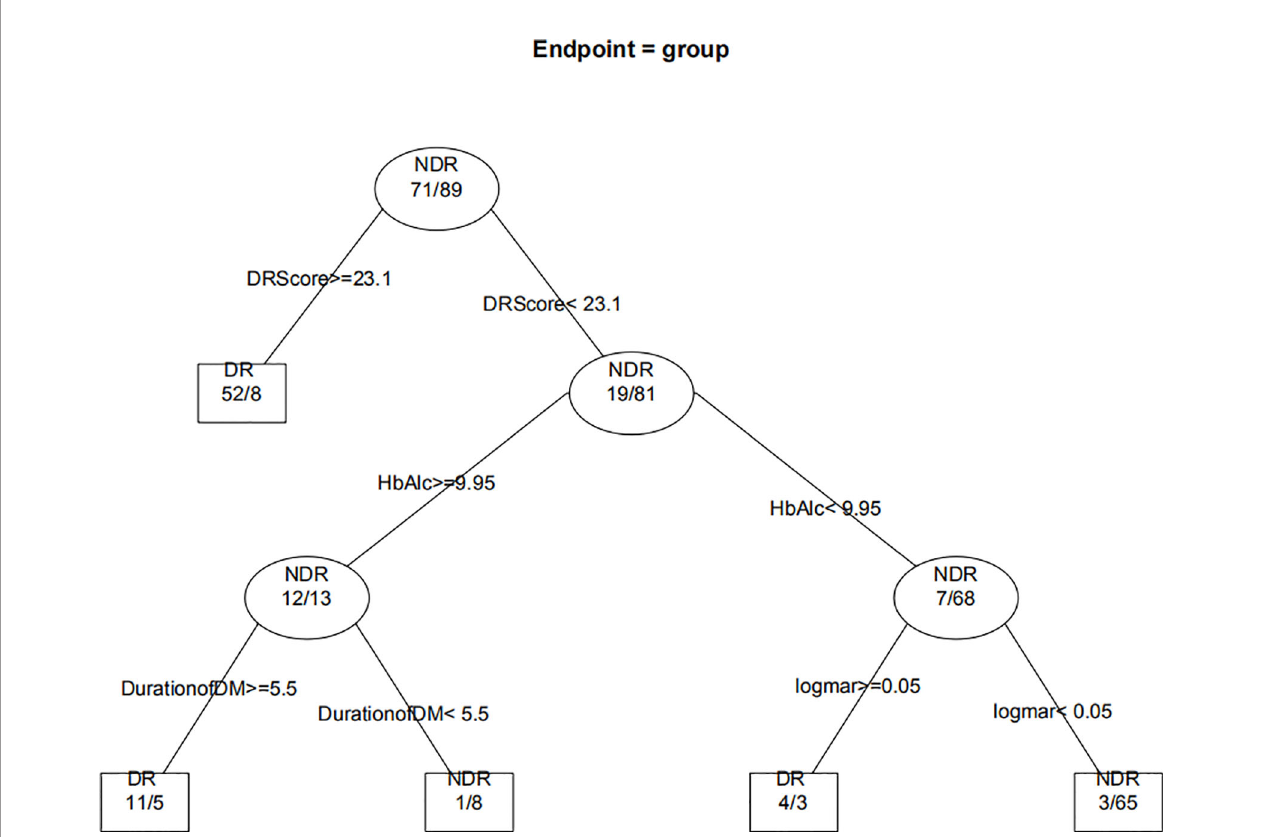
FIGURE 8 | Decision tree for detecting diabetic retinopathy using DR score combined with several factors. The subsets in ellipses means the classi fi cation had not been completed, while the subsets in the boxes mean completed. Subsets in “ DR ” boxes mean “ high risk of DR ” , while “ NDR ” subsets mean “ low risk of DR ” . The numbers in every subset mean “ true DR subjects/true NDR subjects ” . For example, the fi rst box in the upper left corner means 60 subjects were considered to be at high risk for DR, of which 52 were true cases of DR and eight were actually NDR subjects. For the last box, it means 68 subjects were considered to be at low risk for DR, of which three were actually cases of DR and 65 were true NDR subjects.